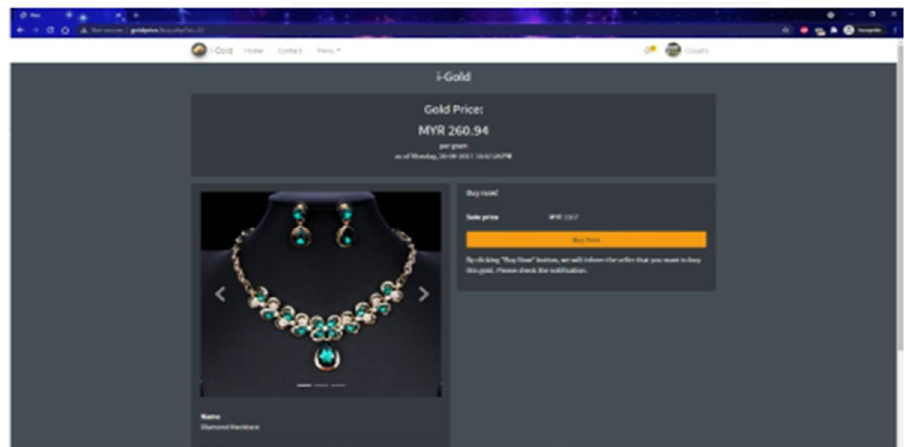
Figure 4. Promo page.